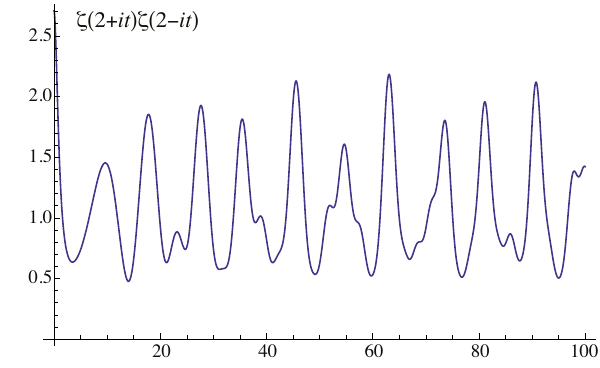
Figure 8. The function ζ (2 + it ) ζ (2 – it ) in the integrand in Eq. (69):